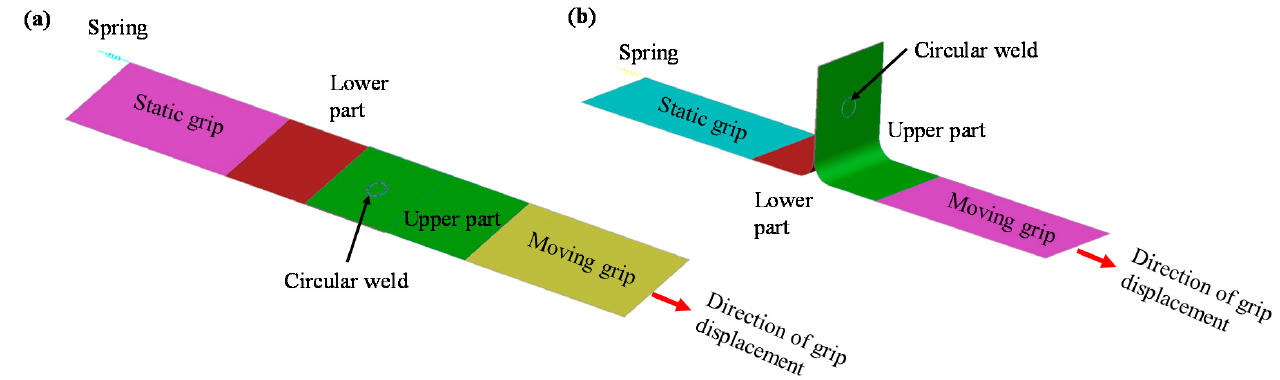
Figure 4. Schematic of test model set-ups: ( a ) lap shear simulation model and ( b ) T-peel simulation model.